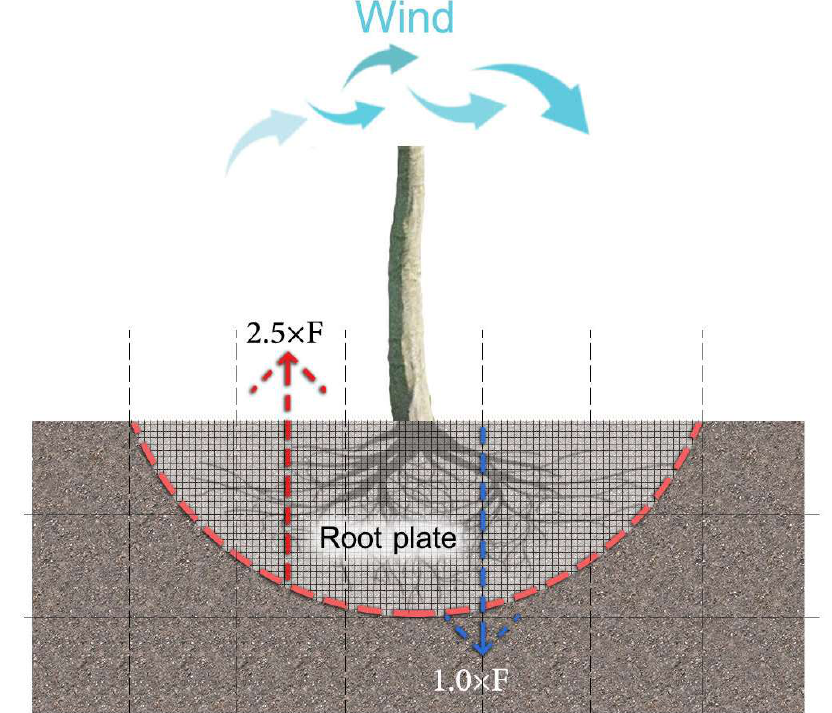
Figure 2. Wind loading and gravity impact of trees.